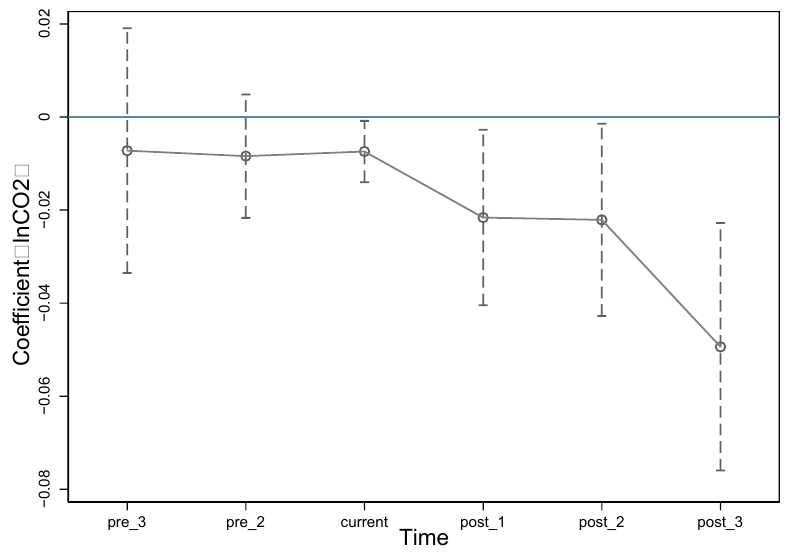
Figure 3. Dynamic effect tests.